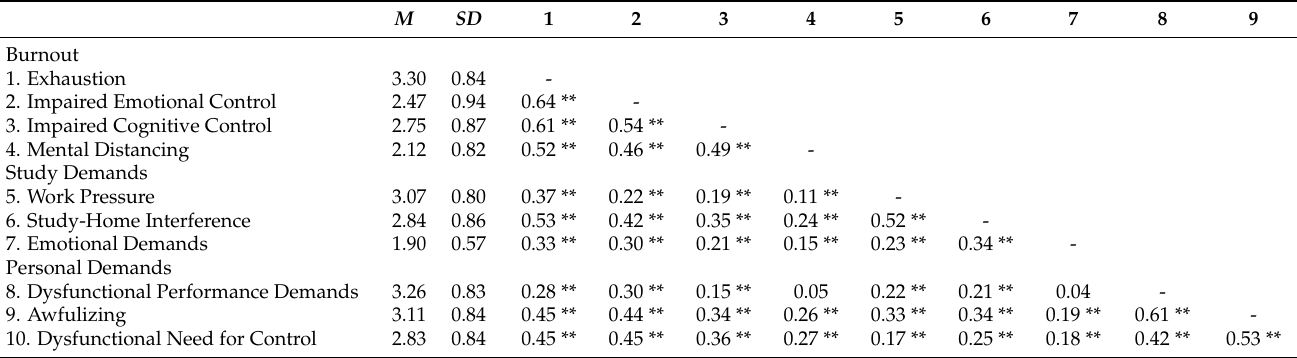
Table 1. Descriptive statistics and Pearson correlations for all study variables ( n = 568).